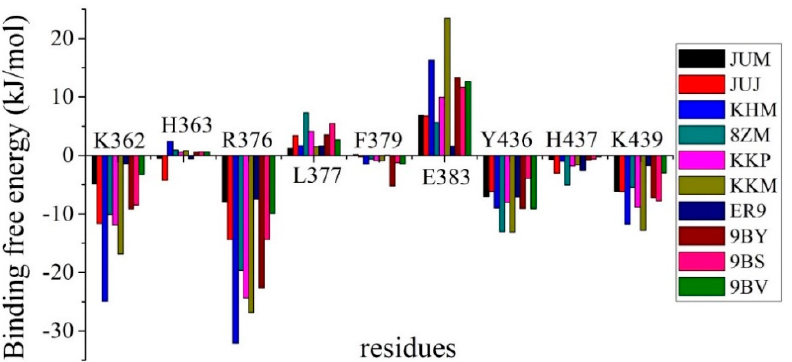
Figure 3. Binding free energies of the residues with major contributions within 6 Å of inhibitors in all hcGAS-inhibitor